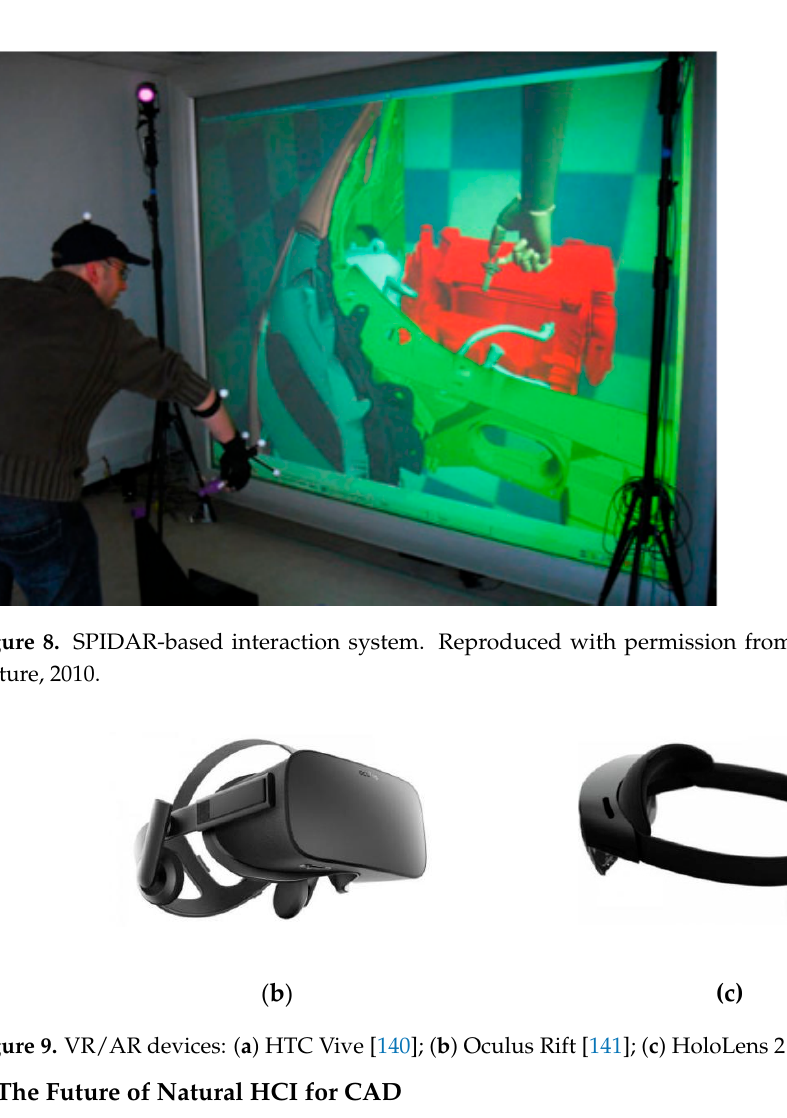
Figure 7. Haptic device for CAD: ( a ) SensAble PHANTom; ( b ) haptic-based device for modeling system. Reproduced with permission from [110], Elsvier, 2005.